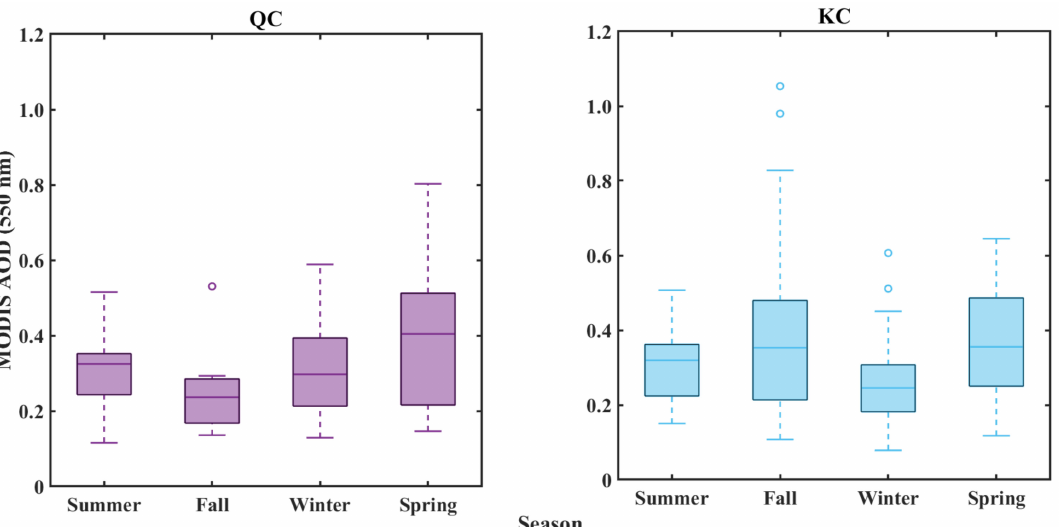
Figure 6. Boxplots of seasonal concentrations of evaluated MODIS AOD values from 2010 to 2020 in Quezon City and Koronadal City; median is shown by the middle line of the box, inter-quantile range is shown by the box, and whiskers represent the ± 2.7 + inter-quantile range.